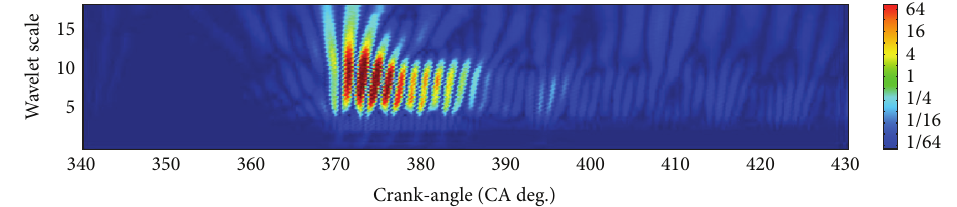
Figure 3: Wavelet transform result in a specific cycle for 1500 rpm